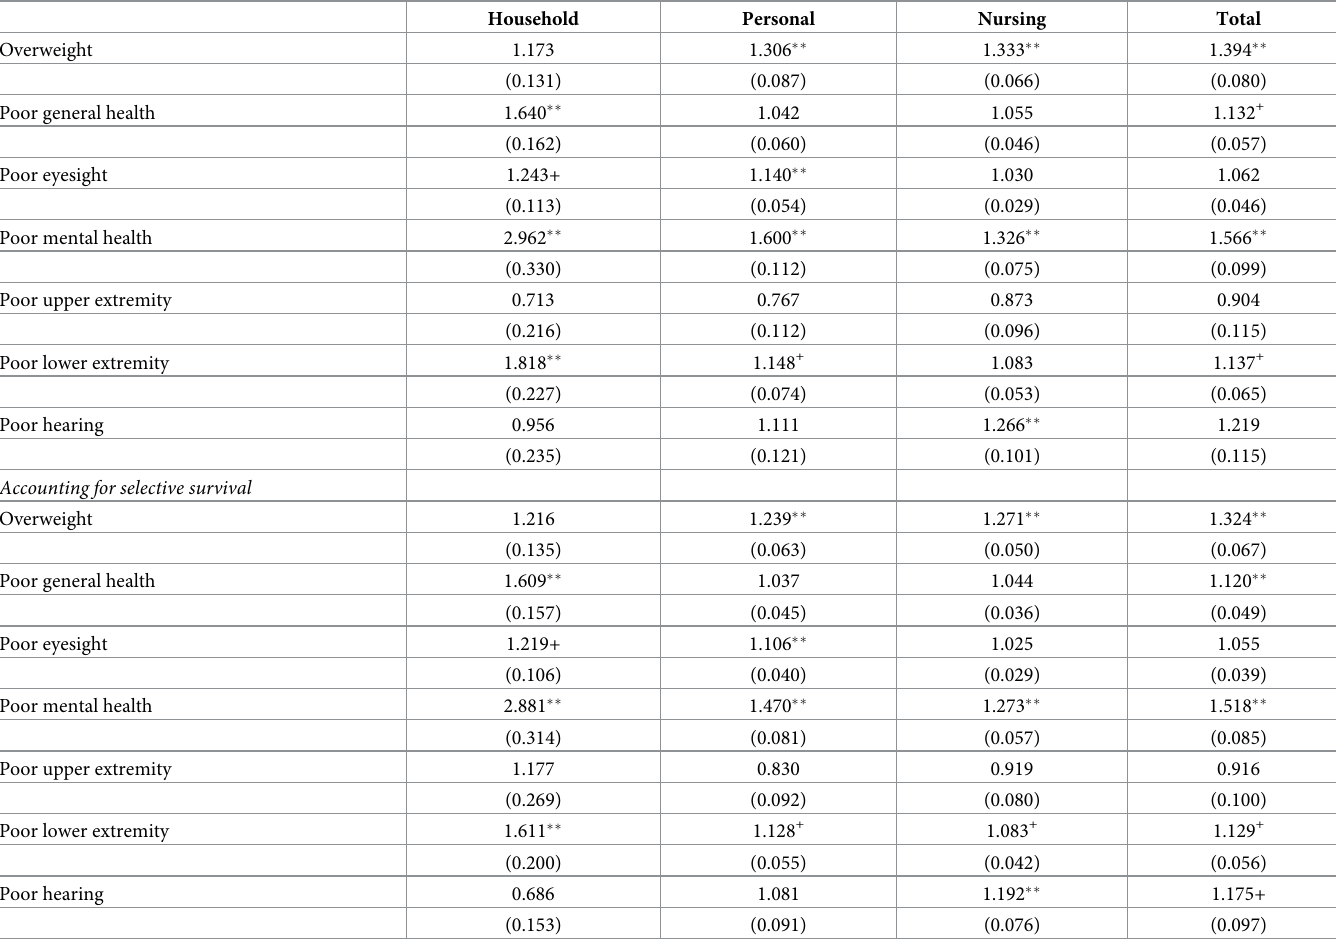
Table 3. Odds ratios panel probit model of early life health on later life home care use.